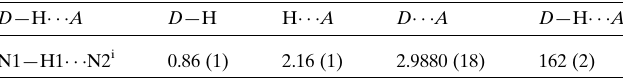
Table 1 Hydrogen-bond geometry (A˚ , (cid:4) ).